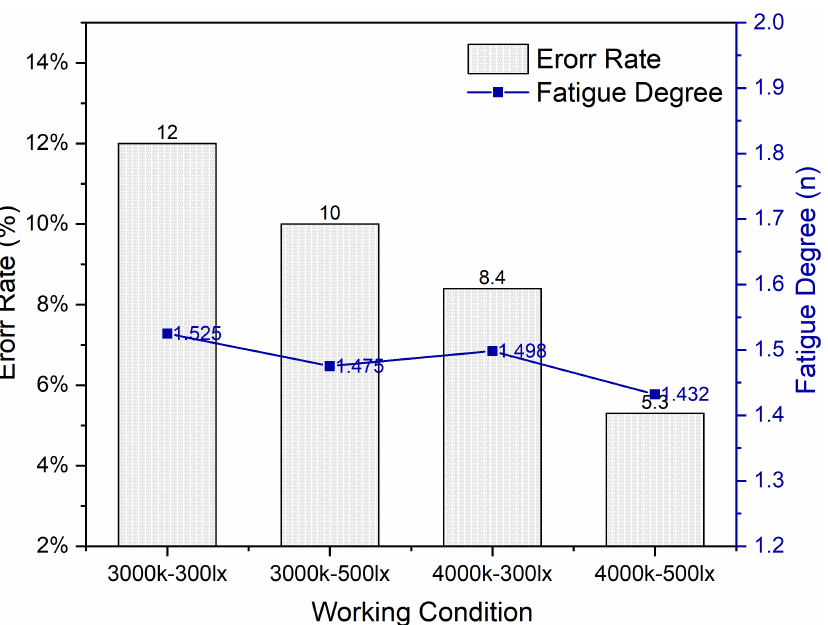
Figure 13. Error rate and fatigue degree trend under different lighting